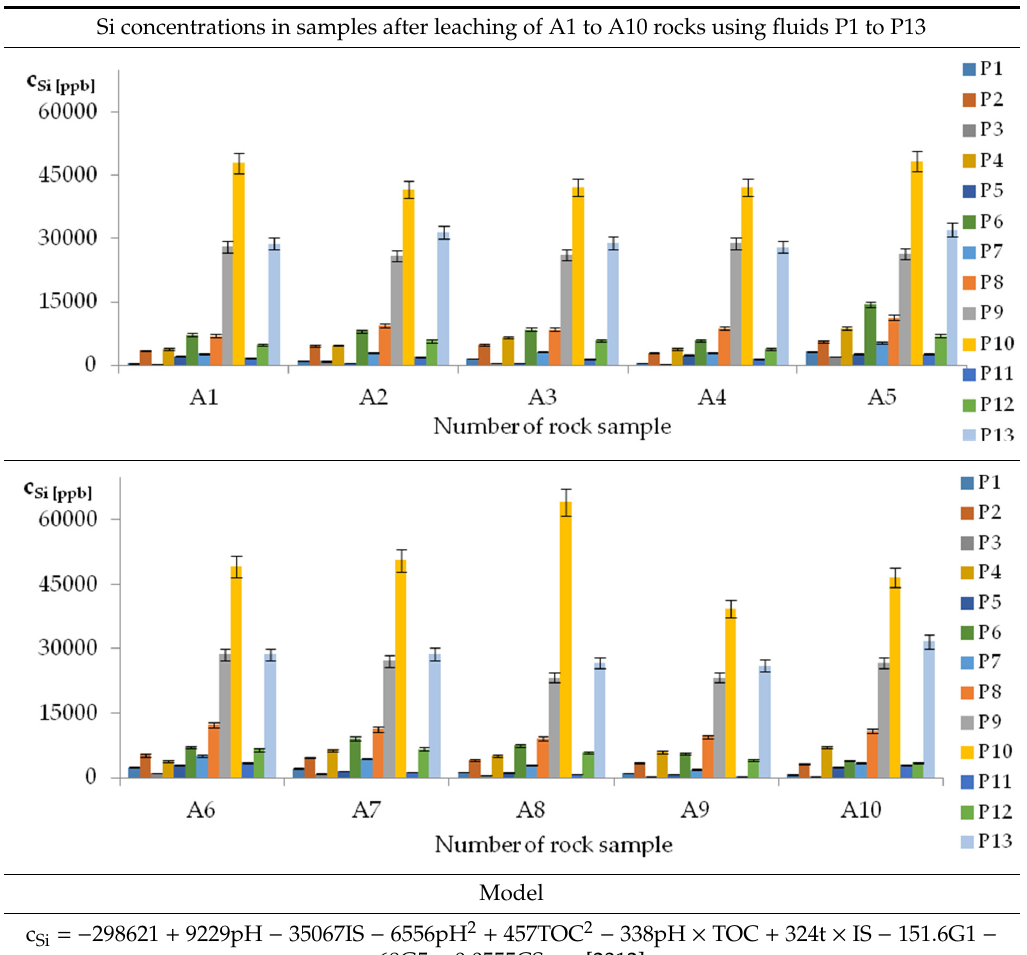
Table 13. Results of leaching samples A1 to A10 rocks using fluids P1 to P13 for Silicon (Si). Si concentrations in samples after leaching of A1 to A10 rocks using fluids P1 to P13